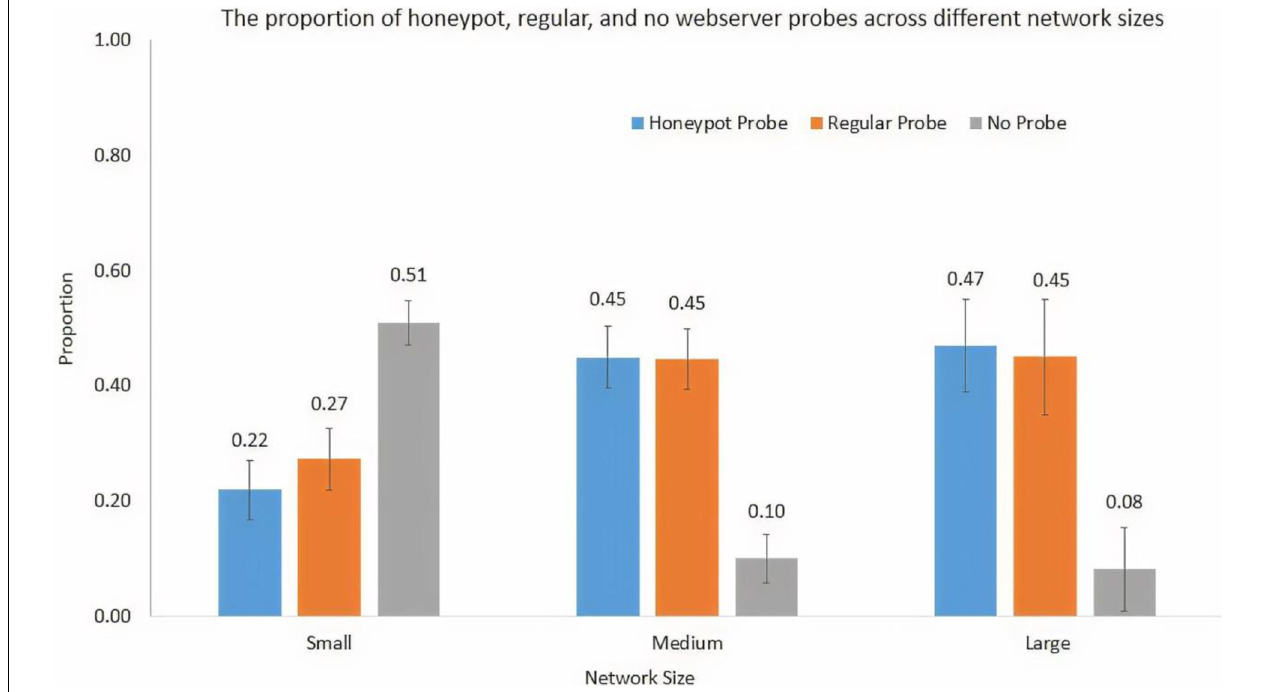
FIGURE 5 | The proportion of honeypot probe, regular probe, and no-probe decisions across different network sizes.